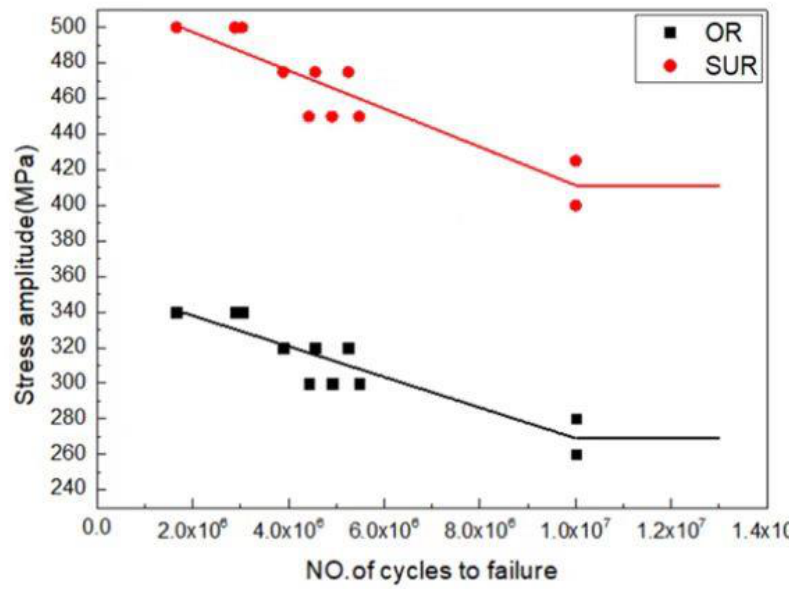
Figure 12. S-N curves of the original and SUR 2 samples.